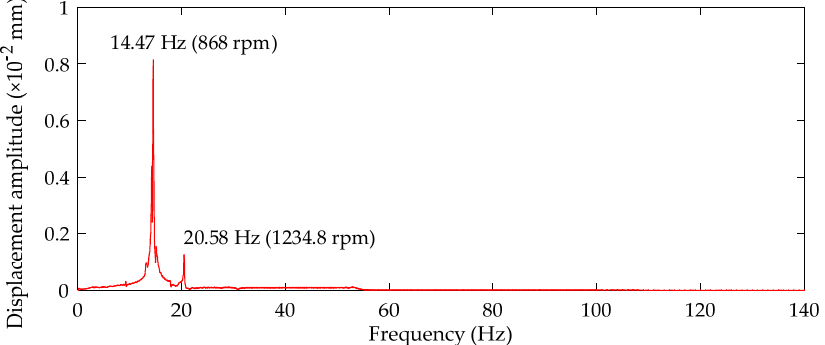
Figure 13. Amplitude-frequency characteristics at the measuring point C under speed-up time of 50 s.